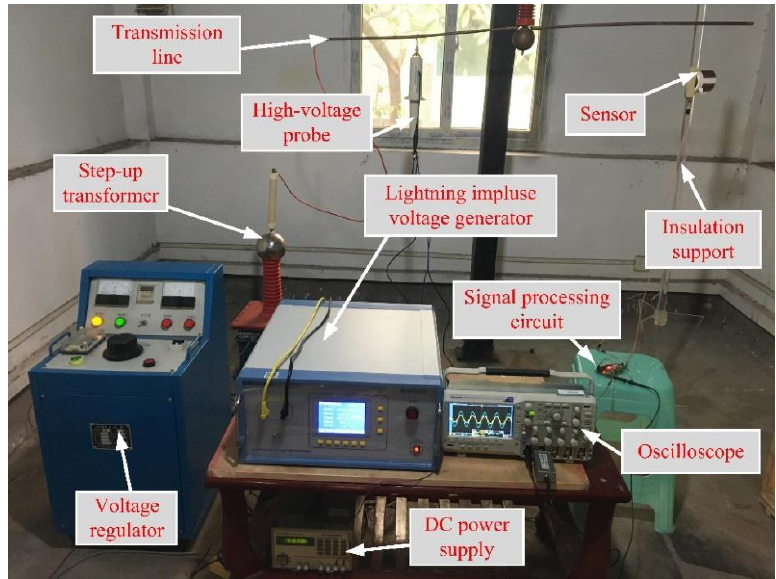
Figure 11. The sensor test platform.